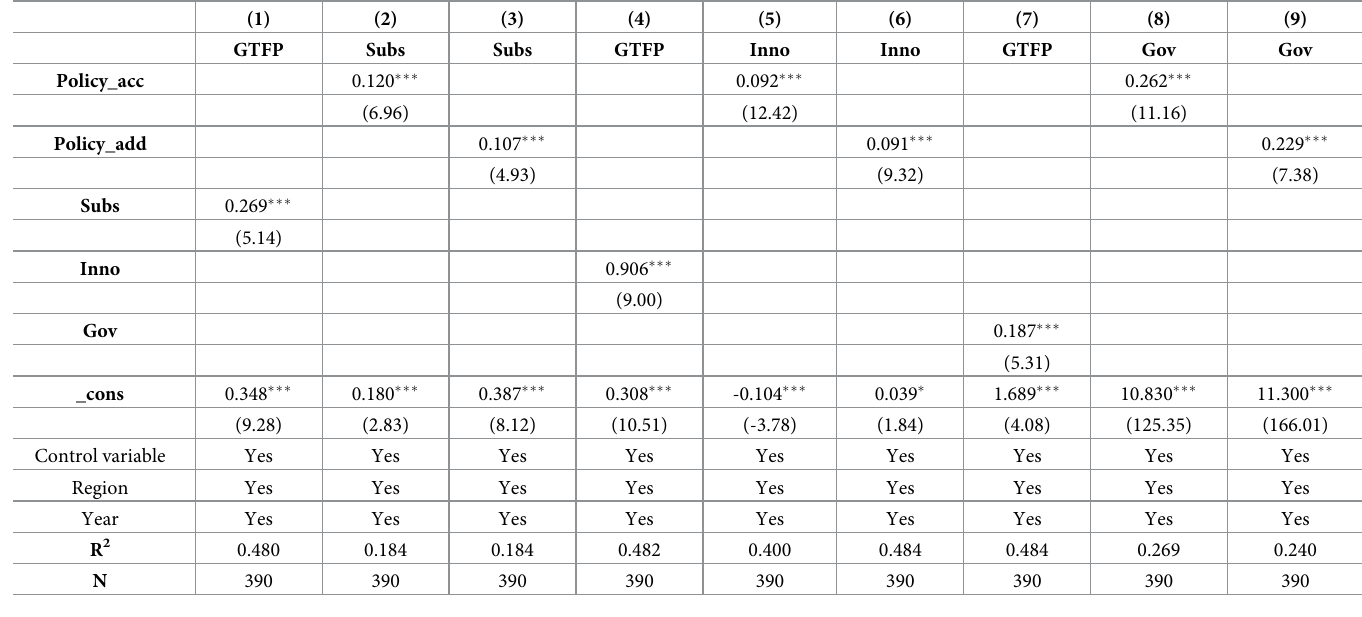
Table 4. Transmission